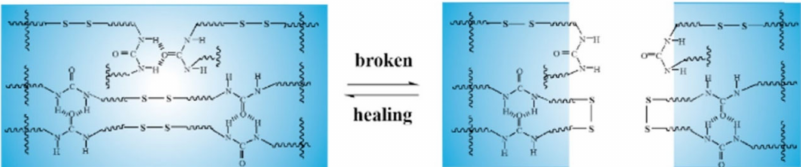
Figure 16. The proposed mechanism of healing for the as-prepared PDMS-PU film. Reproduced from [45] with permission from